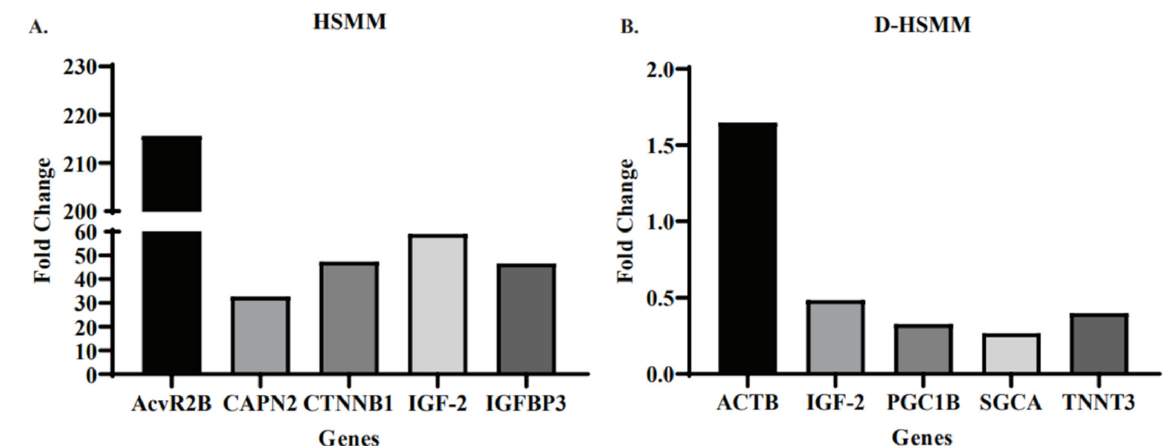
Figure 3. ( A ) The top-5 genes expressed in HSMM following both acute and chronic heat treatments. All five genes expressed the highest change that occurred following the acute treatment, with a range of 32.74–215.61-fold. ( B ) The top-five genes expressed in D-HSMM following both acute and chronic heat treatments. The upregulation of the five genes had a range of